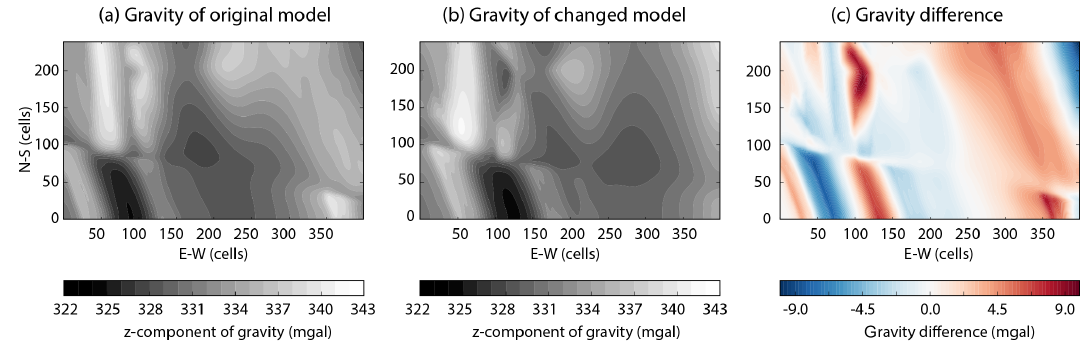
Figure 5. Evaluation of the effect of a wavelength change in a late folding event on the forward calculated gravity field: (a) gravity field of original model, (b) gravity field of model with changed event parameters, and (c) difference plot of gravity